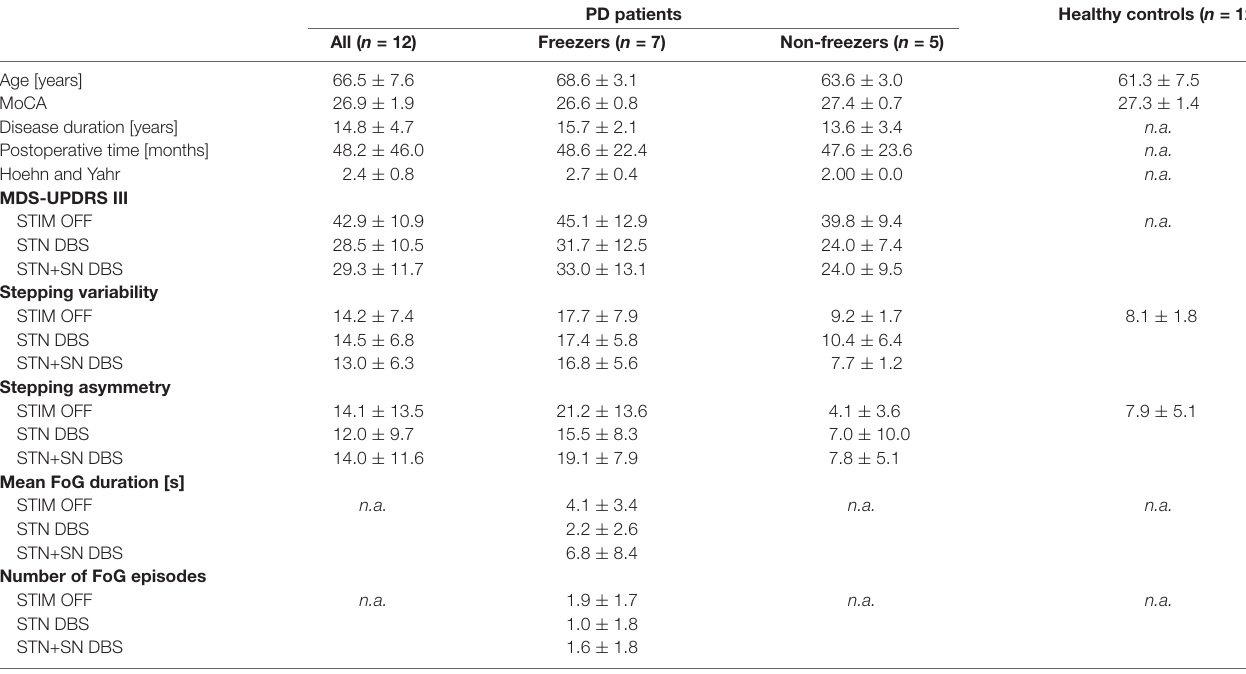
TABLE 1 | Clinical and demographic characteristics of PD patients and healthy matched control